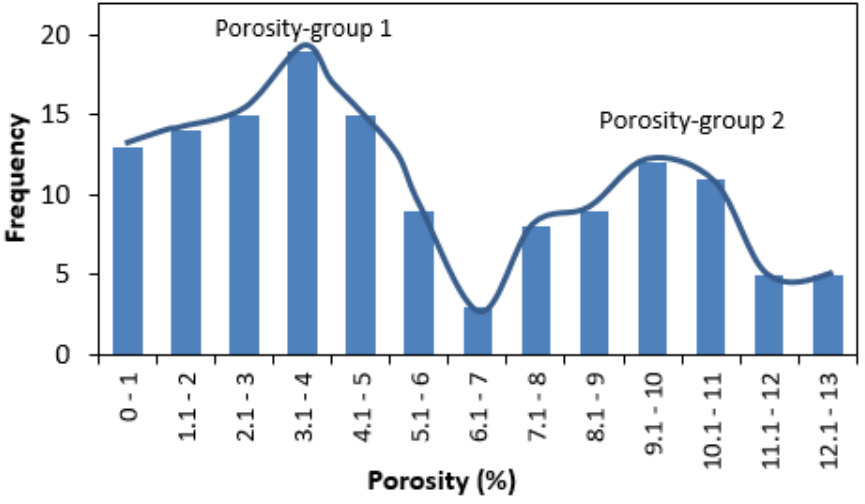
Figure 3. Porosity distribution of 140 rock samples extracted from six wells.